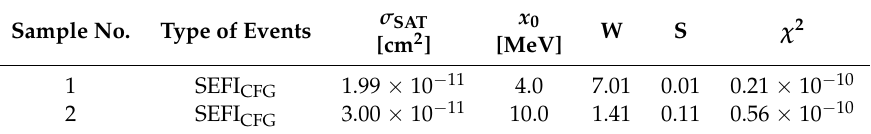
Table 11. Weibull function parameters for SEFI CFG event type based on the χ 2 method. Sample No.